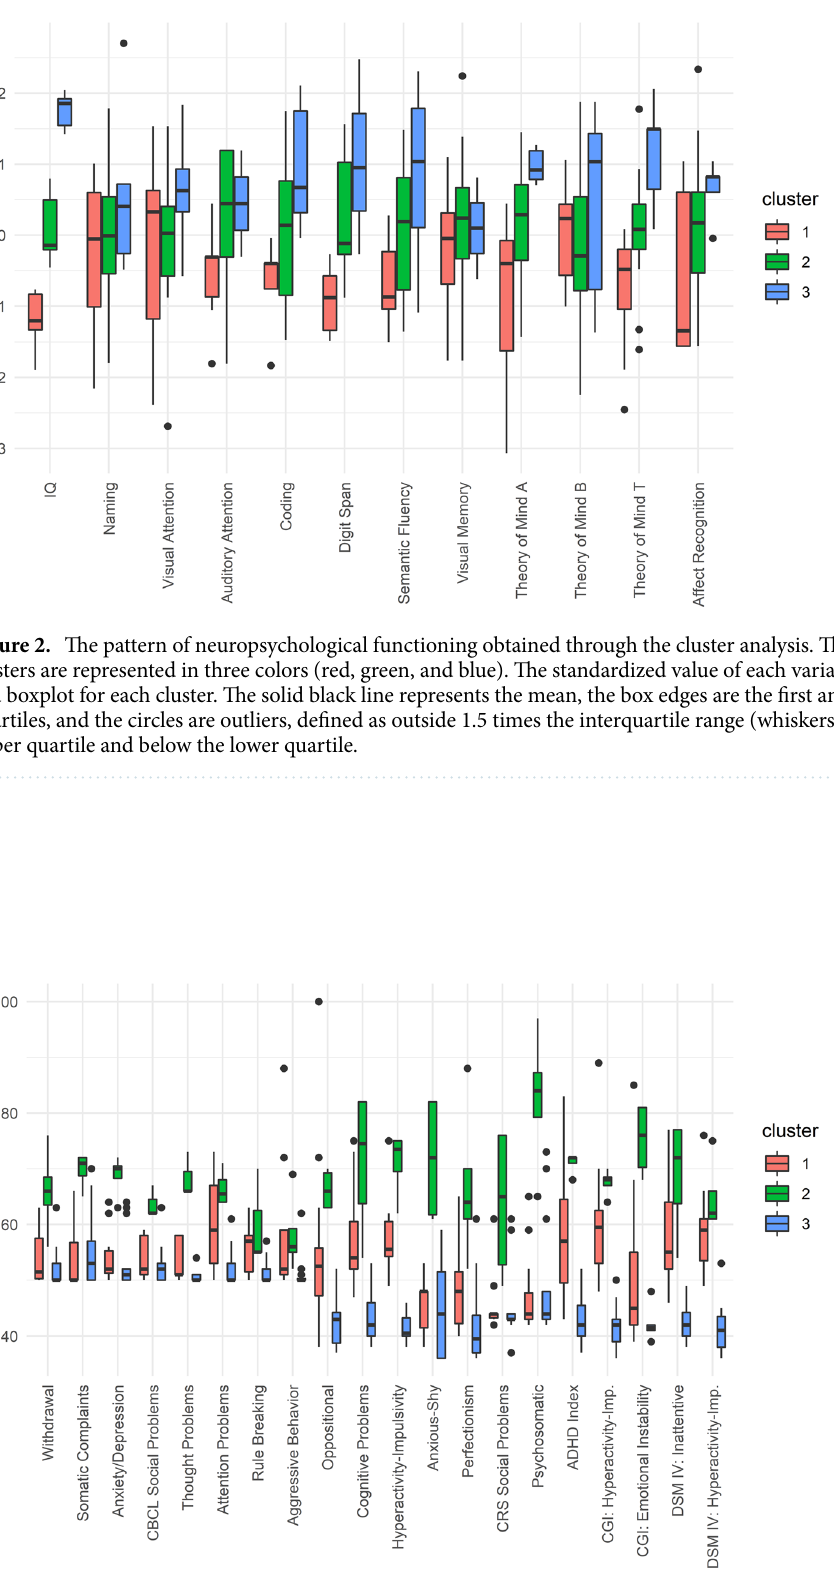
Figure 3. The pattern of psychopathological functioning obtained with the cluster analysis. The three clusters are represented in three colors (red, green, and blue). The standardized value of each variable is depicted as a boxplot for each cluster. The solid black line represents the mean, the box edges are the first and third quartiles, and circles are outliers, defined as outside 1.5 times the interquartile range (whiskers) above the upper quartile and below the lower